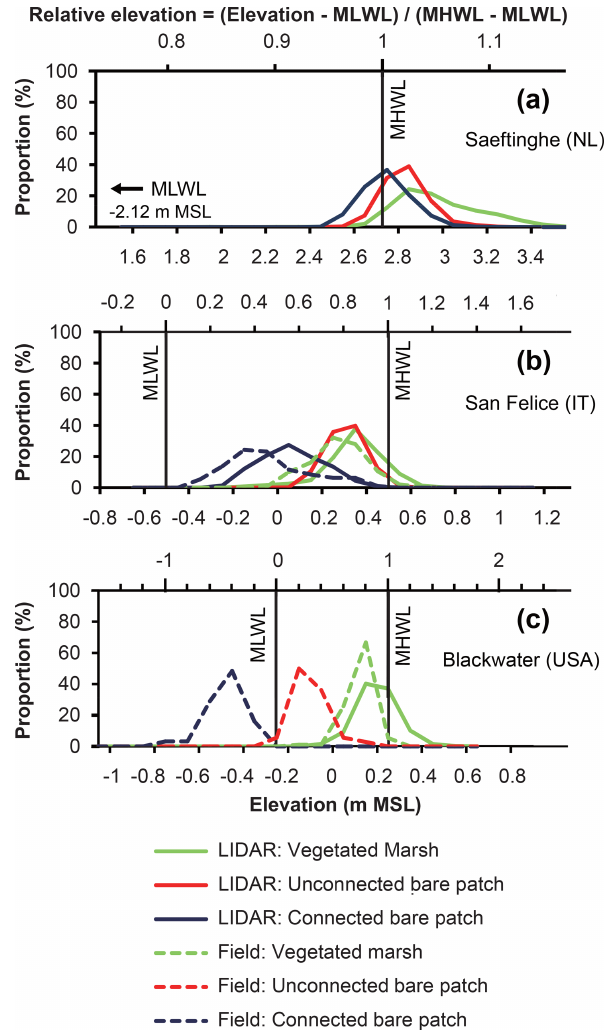
Figure 4. Elevation distribution of vegetated marshes, unconnected bare patches, and connected bare patches based on lidar surveys and field surveys for (a) Saeftinghe, (b) San Felice, and (c) Blackwater. In each figure, the bottom x axis shows the absolute elevation (in meters relative to mean sea level) and the top x axis shows the rel- ative elevation (dimensionless, as defined in Eq. 1). The proportion on the y axis is calculated based on lidar or field measurements as the number of pixels or samples in each elevation class (every 0.1m) relative to the total number of pixels or samples for each cat- egory. The total numbers in each category are given in Table 1. The MLWL in Saeftinghe is 2.12m lower than m.s.l., which is outside of the range of the main x axis in (a) . MLWL and MHWL defini- tions at Blackwater are approximate since water level changes are dominated by meteorological rather than astronomical influences. Field data were added to lidar data for San Felice and Blackwater, because bare patches were partly covered there by water, which ob- structs lidar sensing of the soil surface beneath the water surface. In Saeftinghe all bare patches were drained at low tides, and lidar measurements are not obstructed here by water